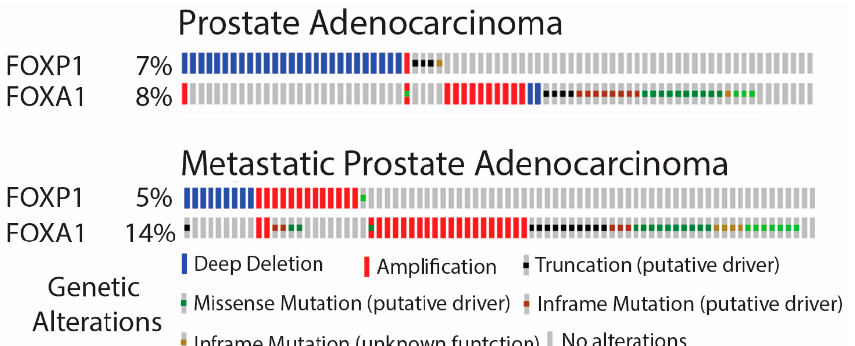
Figure 1. FOXA1 and FOXP1 are highly mutated in primary and metastatic prostate adenocarcinoma. The mutation frequency of FOXA1 and FOXP1 in primary PCa was assessed in a TCGA data set containing 501 samples (Firehose Legacy). The mutation burden in metastatic prostate cancer was assessed in the SU2C/PCF Dream Team data set containing 444 samples. Data were generated